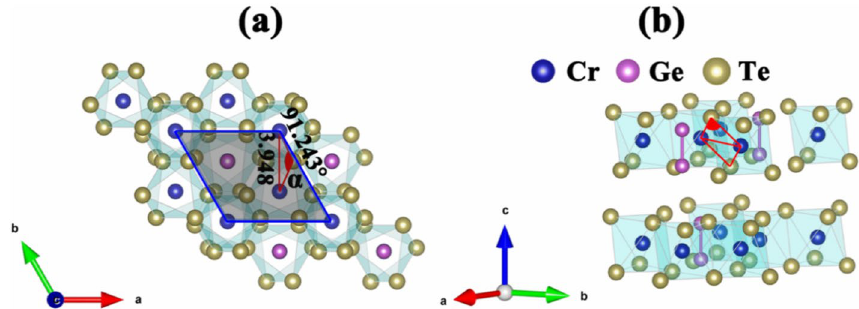
Figure 1. ( a ) Top and ( b ) side views for pristine bilayer Cr 2 Ge 2 Te 6 in AB stacking. Blue, purple, and yellow balls represent Cr, Ge, and Te atoms, respectively. The gray shaded region denotes the unit cell. The red shaded areas indicate the Cr–Te–Cr angle α and the bond between the nearest-neighbor Cr atoms are connected by red solid lines.